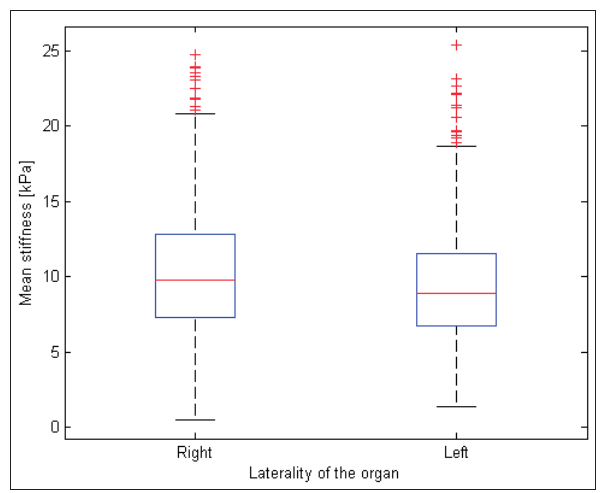
Fig. 5. Comparison of mean stiffness in all organs on contra- lateral